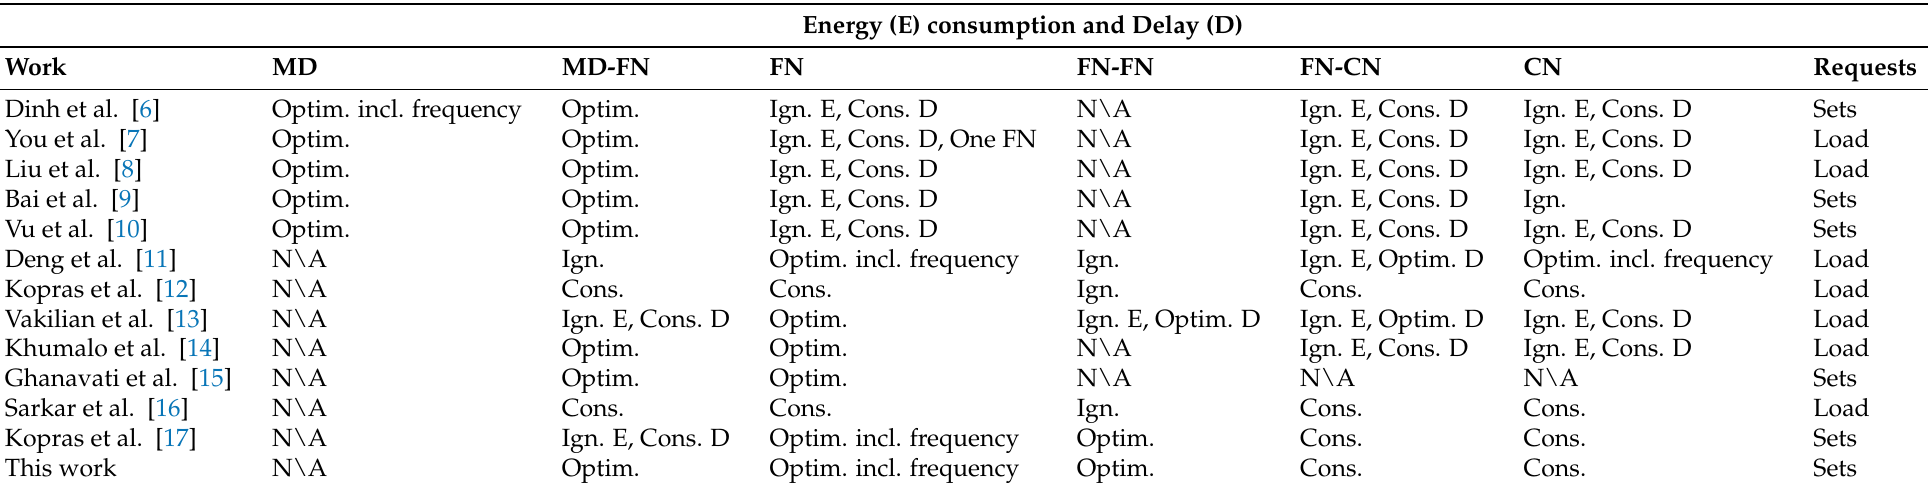
Table 1. Comparison with related